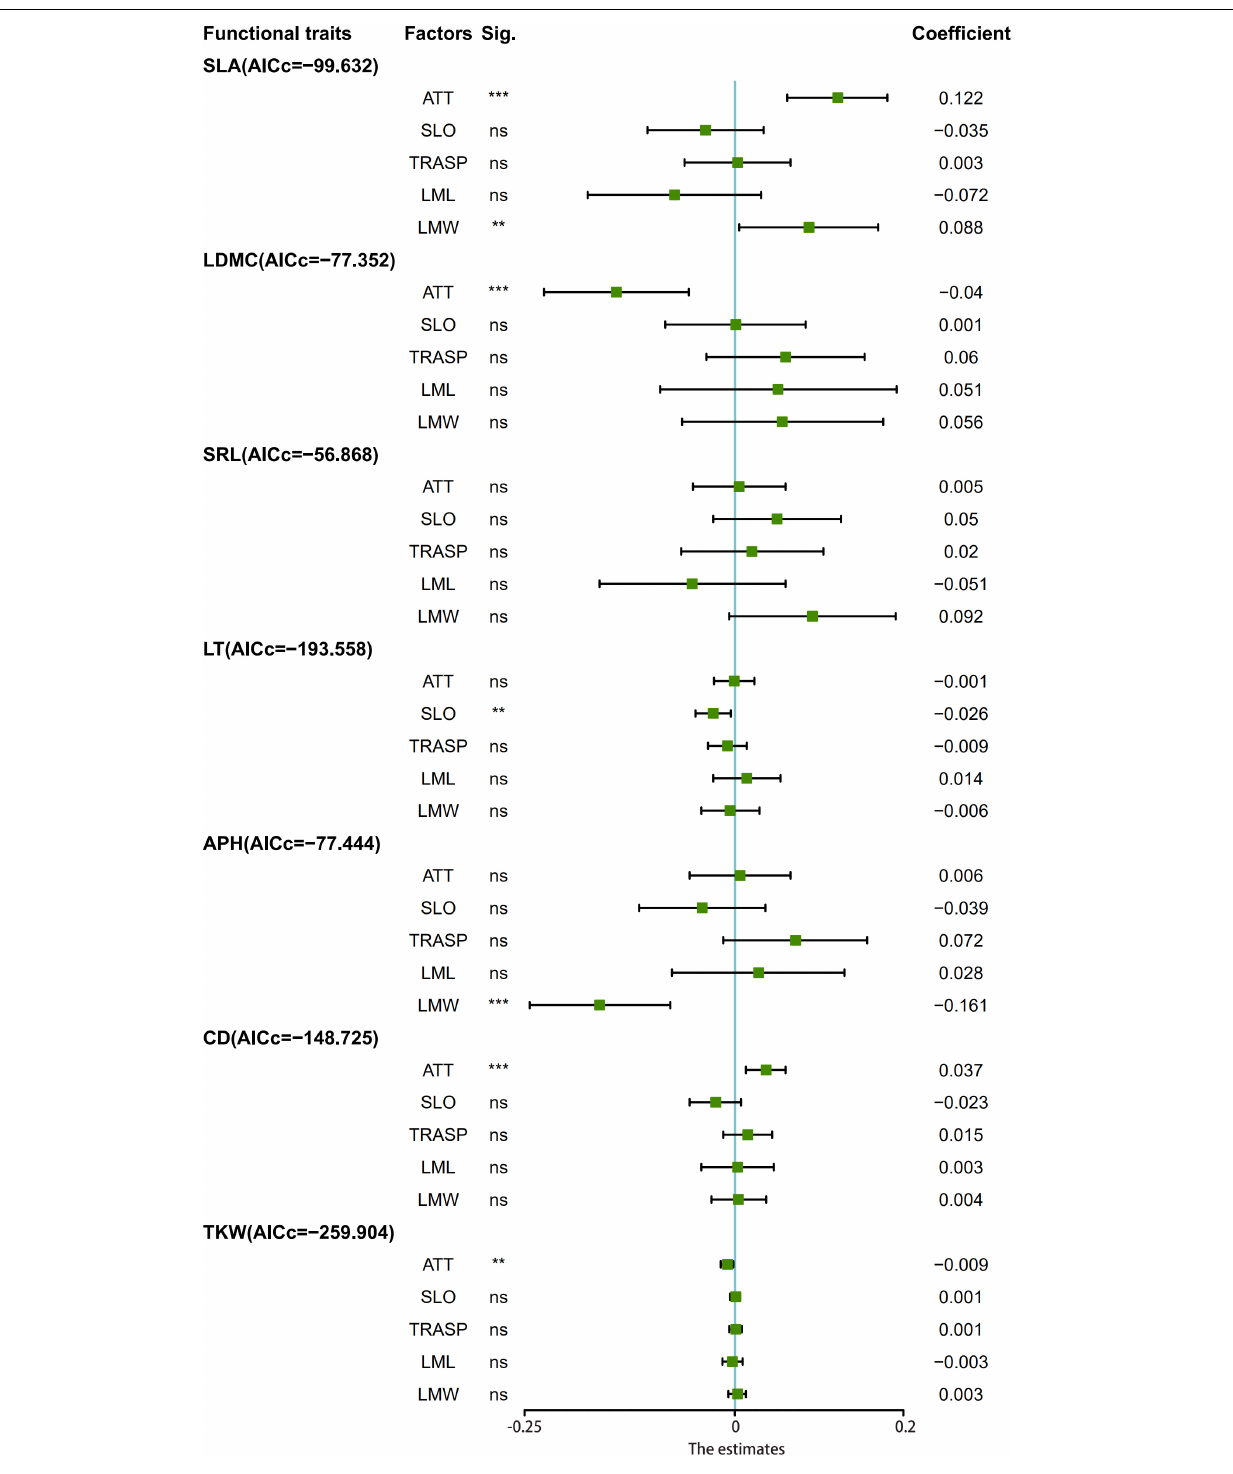
Frontiers in Ecology and Evolution |